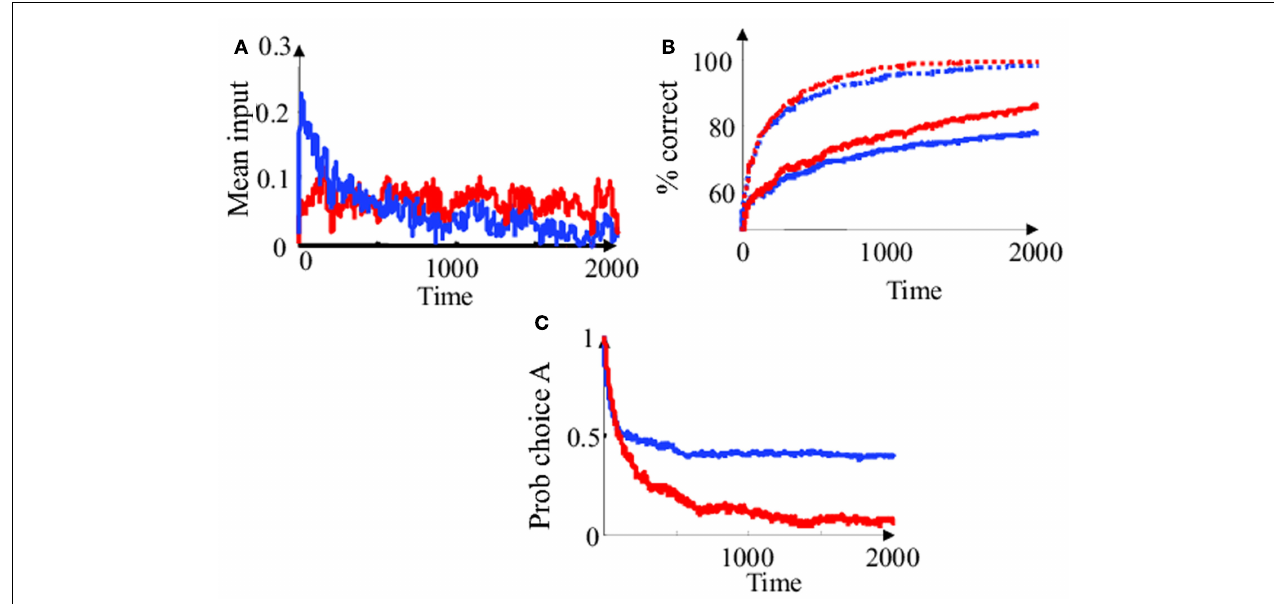
Plain red line: diffusion model at low coherence ( c = 0.1). Dotted red line: Bayesian model at higher coherence ( c = 0.5). In contrast to the diffusion model, the Bayesian model stops integrating early in the trial (i.e., the probability of correct choice saturates whereas it keeps increasing for the diffusion model). (C) Probability of choosing A in zero coherence trial ( c = 0), with a prior favoring choice A ( L o = 0.6), as a function of the duration of stimulus presentation. Since the input is pure noise, optimal strategy (if coherence was known) would be to always respond “A” (i.e., probability of choice A should be 1).The Bayesian model saturates to a suboptimal but still high probability of choice A. In the diffusion model,